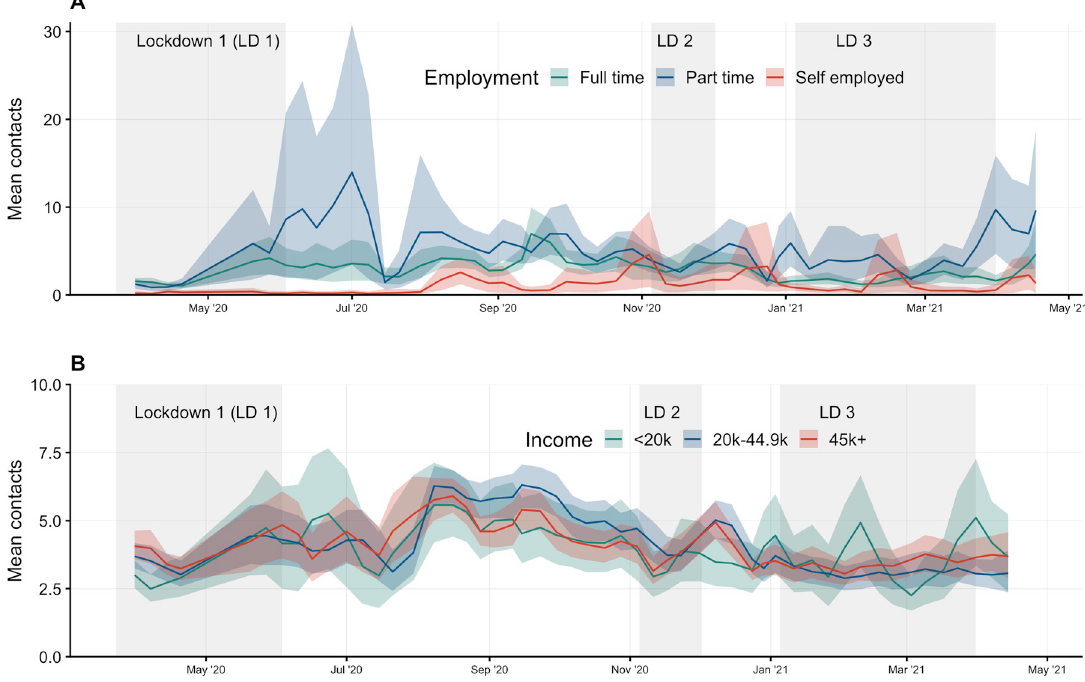
Fig 5. Mean contacts by employment and income status. Mean contacts of participants who worked on the previous day and their workplace was open on the previous day weighted by age, gender, and weekday. (A) By employment type: full time, part time, or self- employed. (B) By annual income level: less than £20k, £20k to £44.9k, and over £45k. LD,